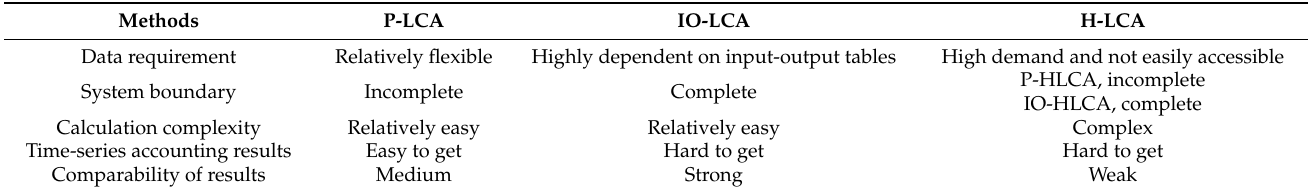
Figure 3. Classification of building direct and indirect emissions. Table 2. Comparison of accounting methods for embodied carbon